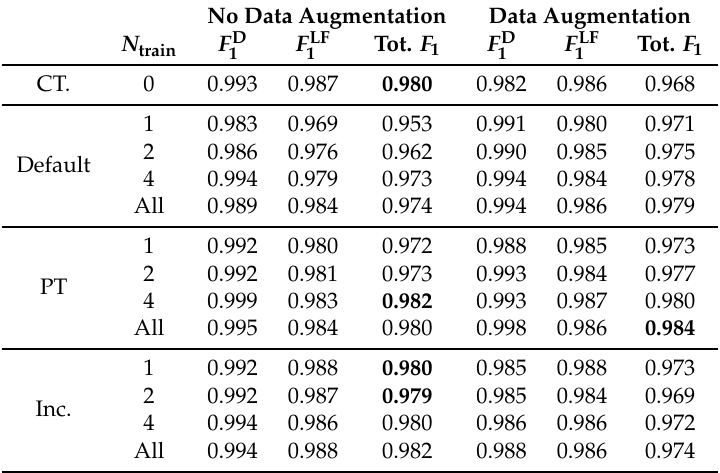
Table 5. Evaluation how the number of training instances influence the accuracy of pages with an unknown layout. All results are the averages of a five fold of each data set part. Only N train pages are chosen for actual training. The major row grouping shows if pages of the remaining parts are included during training: Either no data is used (Default), a pretrained model on the data is used (PT), a large data set comprising all other data which is extended by N train is used (Inc.) The first row shows the cross-training (CT.) results of Table 4 without any data of the target layout. The two major column sections show the results with and without data augmentation on the training data. The best values for each N train are marked